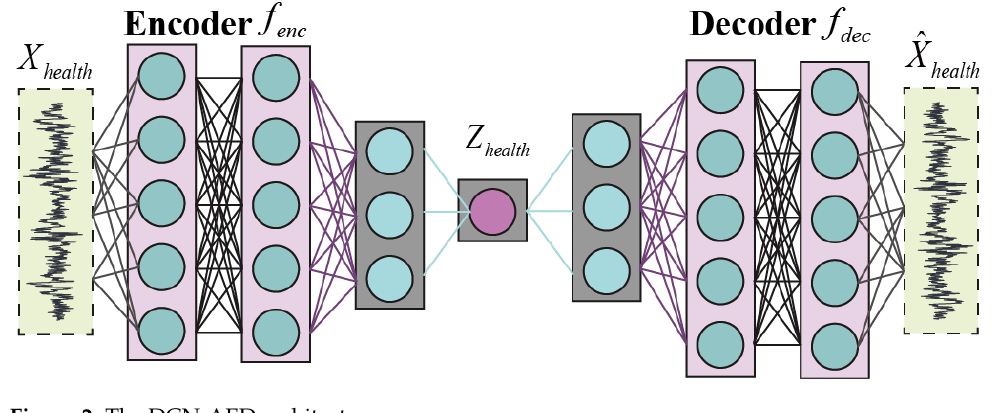
Figure 2. The DCN-AED architecture. Table 2. Simulation cases and corresponding vibration